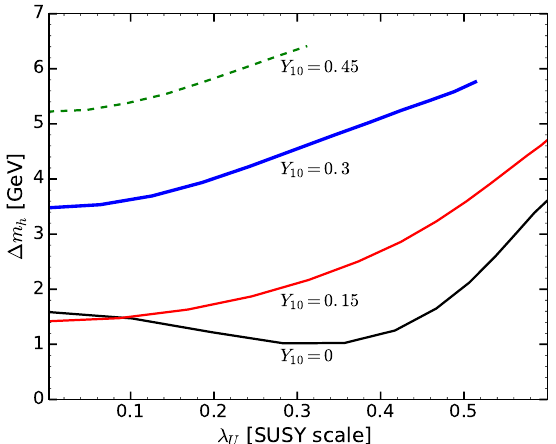
Figure 3. Higgs mass di(cid:11)erence in the QUE model with respect to the CMSSM as a function of (cid:21) U (SUSY scale) for various values of Y 10 at the GUT scale. From bottom to top Y 10 = 0 ; 0 : 15 ; 0 : 3 ; 0 : 45. These values correspond roughly to 0, 0.5, 0.75, and 1 at the SUSY scale. The values of m 0 , m 1 = 2 , A 0 , and tan (cid:12) are (cid:12)xed as in the QUE benchmark point, see section 5.1.